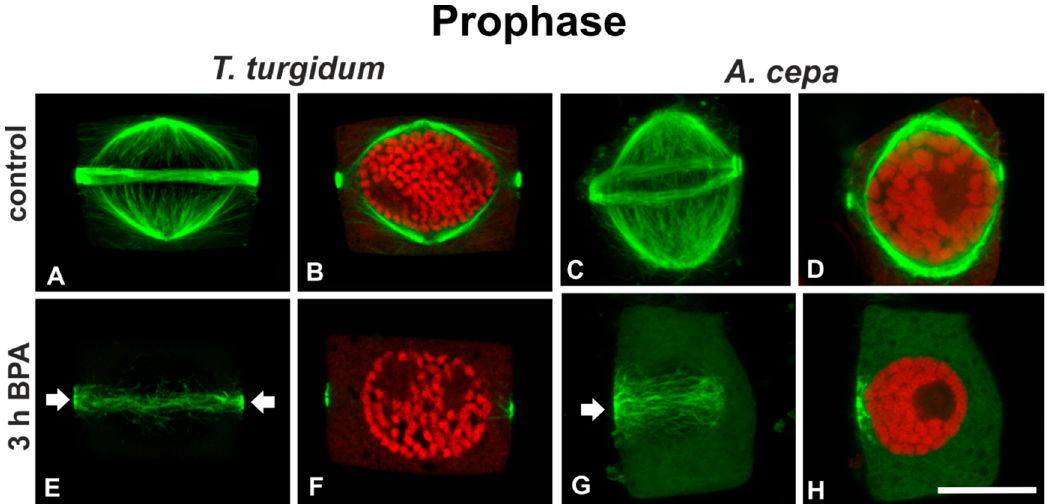
Figure 3. ( A , C , E , G ) Tubulin immunolocalization (green, projections of CLSM sections) and ( B , D , F , H ) propidium iodide DNA staining (red, single CLSM sections) in prophase (see chromatin condensation) root cells. Arrows in ( E ) and ( G ) point to aberrantly organized pre-prophase microtubule bands of BPA-affected cells. Note the absence of perinuclear spindles in ( F ) and ( H ). Scale bar: 10 μ m.